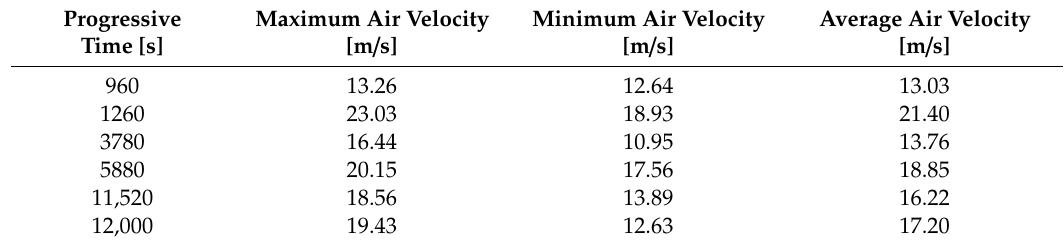
Table 1. Air speed values obtained by Tecora Flowtest.